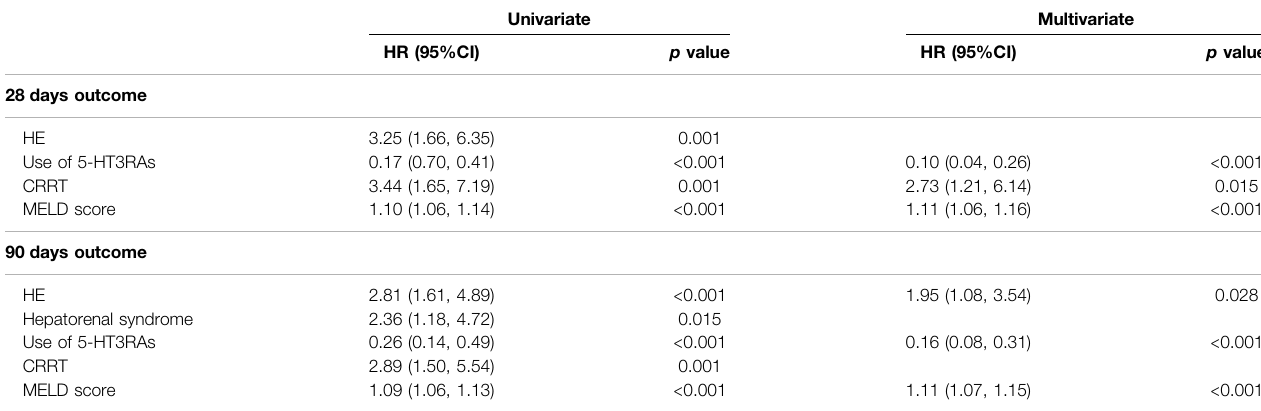
TABLE 3 | Univariate and multivariate Cox regression analyses of variables and 28 and 90 days outcomes after propensity score matching. Univariate